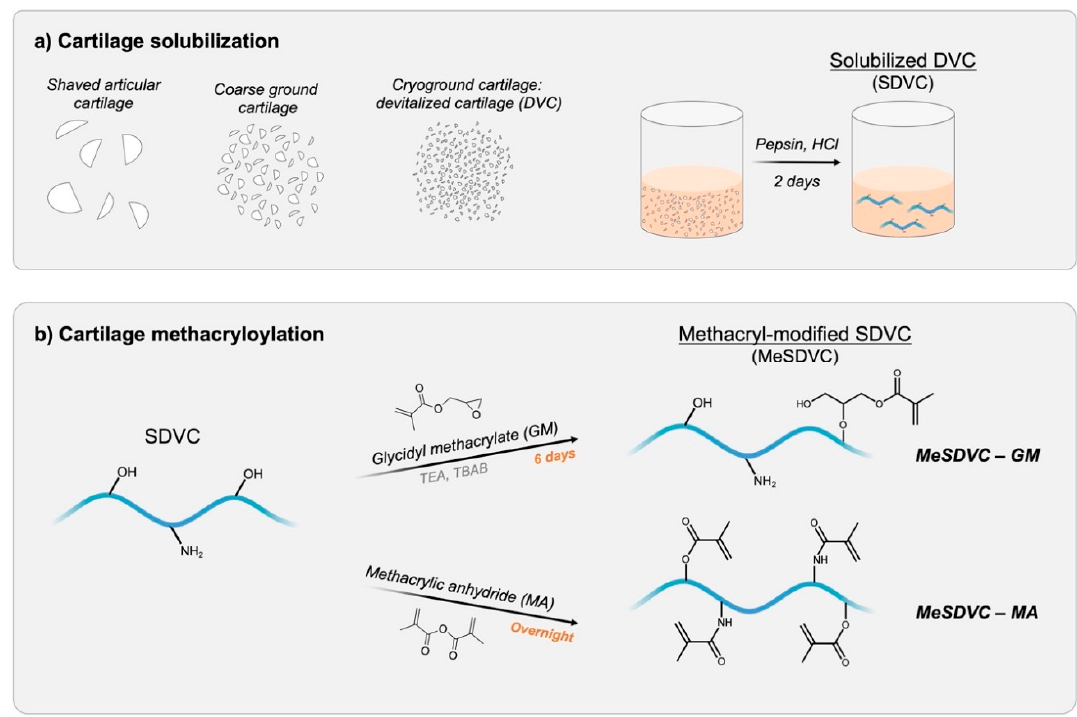
Figure 1. Illustration of cartilage processing and functionalization. ( a ) Devitalized cartilage (DVC) particles were formed by shaving porcine articular cartilage from the knee, freezing, coarse-grinding with dry ice, and cryogrinding into smaller particles using a cryogenic tissue grinder to form devitalized cartilage (DVC). To form solubilized DVC (SDVC), the DVC particles were solubilized with pepsin in hydrochloric acid (HCl) for 2 days, dialyzed, and lyophilized. ( b ) SDVC was methacryloylated with either (1) glycidyl methacrylate (GM) plus triethylamine (TEA) and tetrabutylammonium bromide (TBAB) for 6 days or (2) methacrylic anhydride (MA) overnight. GM functionalizes mostly hydroxyls and carboxyls of the polymers present in the cartilage matrix (e.g., collagens, hyaluronic acid) to form MeSDVC—GM. In addition to hydroxyls and carboxyls, MA additionally functionalizes amines to form MeSDVC—MA.